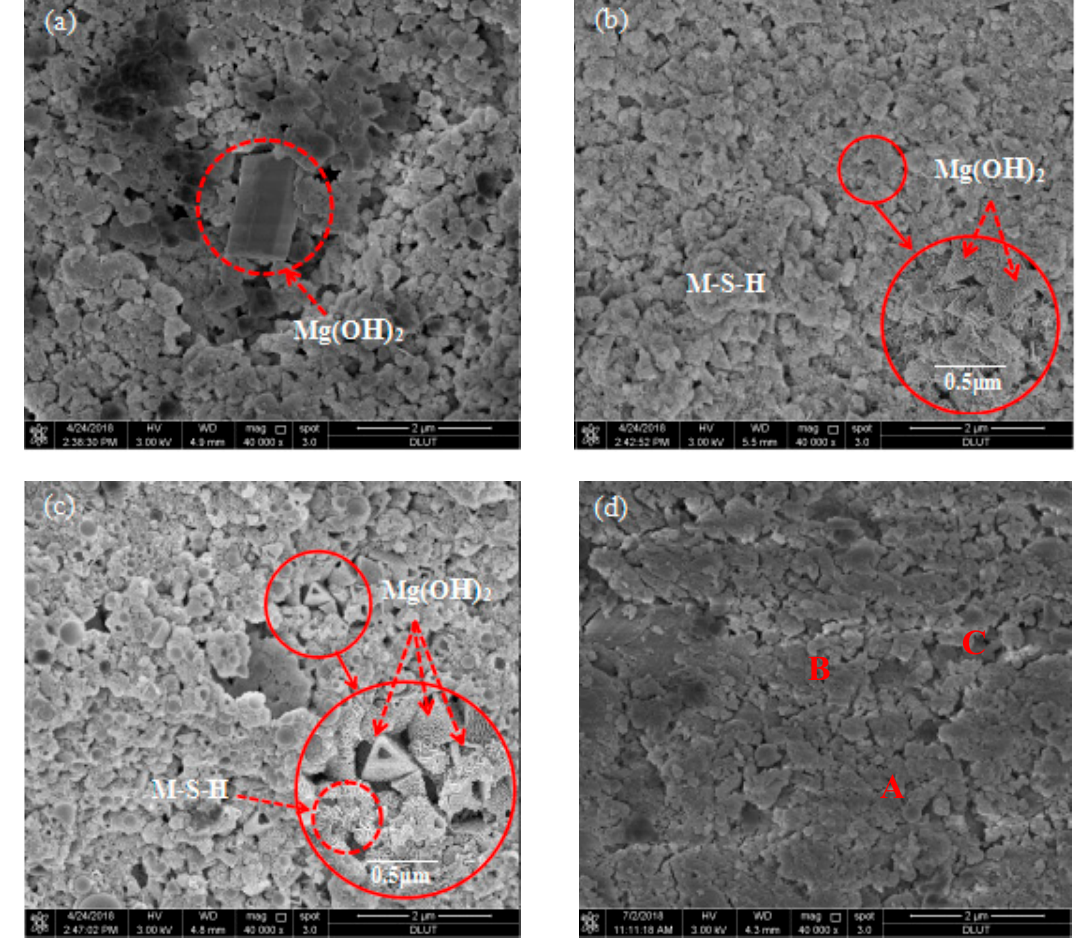
Figure 7. Microstructures of samples cured for different periods: ( a ) 3; ( b ) 7; ( c ) 28; and ( d ) 90 d. Table 3. Energy-dispersive X-ray spectroscopy (XDS) results of the M–S–H system-solidified body with 1.6 wt % Cs.